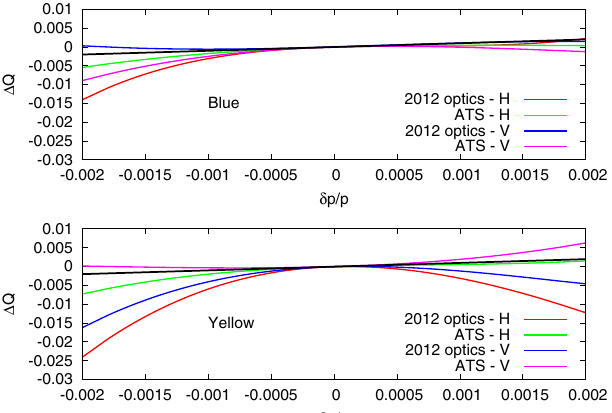
FIG. 6. Blue (top) and Yellow (bottom) non-linear tune dependence on the momentum deviation δ p=p for the 2012 lattice and the 2015 ATS optics. The black line in both plots corresponds to a linear chromaticity Q 0 ¼ þ 1 .